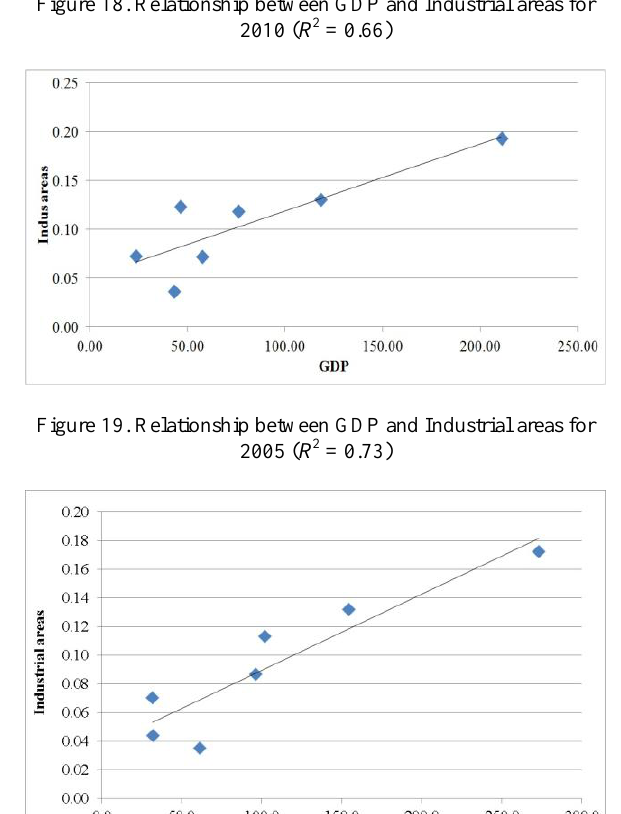
Figure 21. Relationship between the Percentage of Built-up areas and Total employment without Edmonton City for 2005 (R2 =